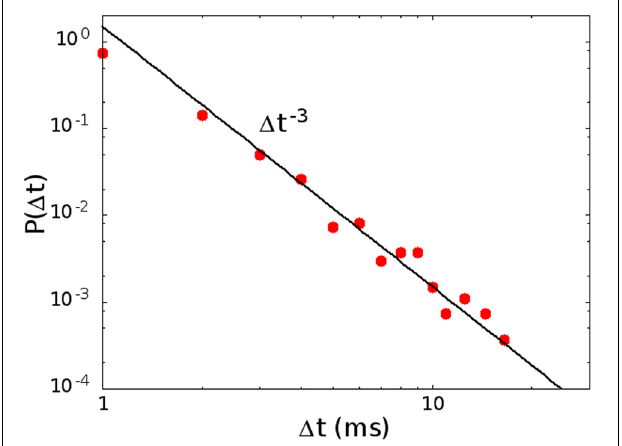
FIGURE 7 | The distribution of waiting times P ( (cid:6) t ) in the region of high activity, for H 0 /(cid:4) = 0 . 250, α = 0 . 08ms − 1 (point C in Figure 2B). In this case the plateau at high values of the waiting time, corresponding to down states, disappears, because the replay of the patterns becomes continuous, and only the power law, corresponding to the concatenation of correlated avalanches inside an up state, is observed.